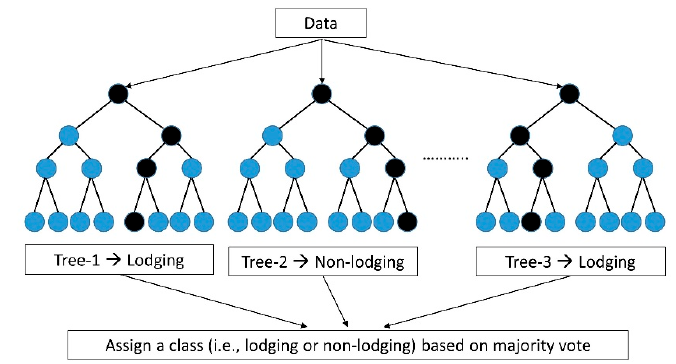
Figure 4. Random forest classifier classification based on the majority vote.